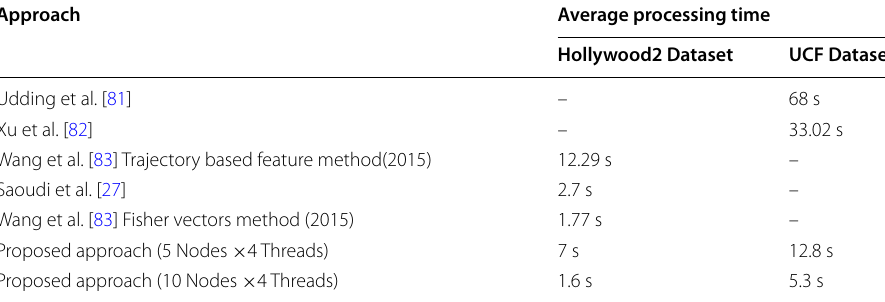
Table 3 Performance comparison of our results to the state of art Approach Average processing